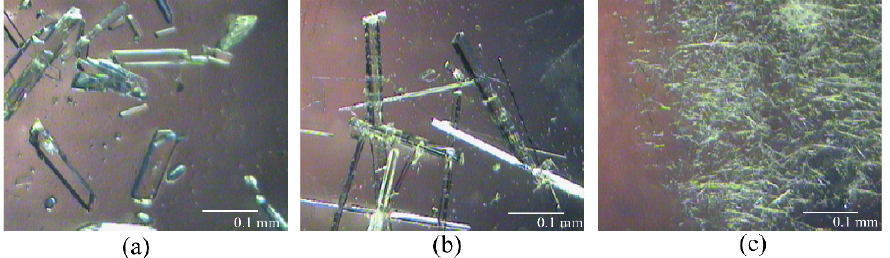
Figure 1. Photographs of ( a ) Form I, ( b ) Form II, and ( c ) Form III.